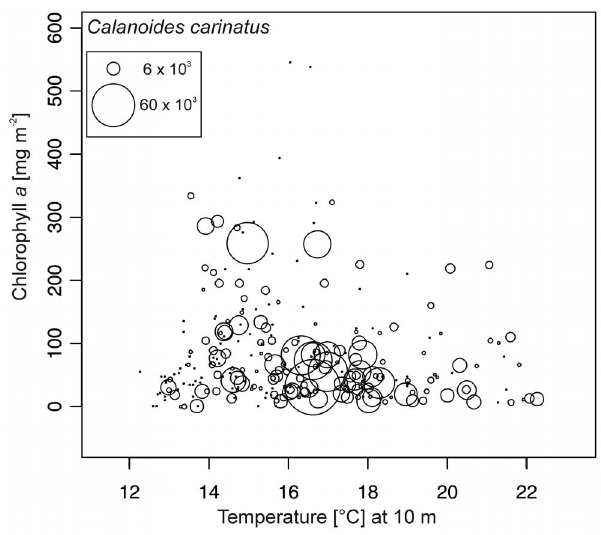
Figure 11. Abundances (no. m 2 2 ) of Calanoides carinatus in relation to chlorophyll a concentration and temperature at 10 m depth. The area of each circle is proportional to the abundance shown in the